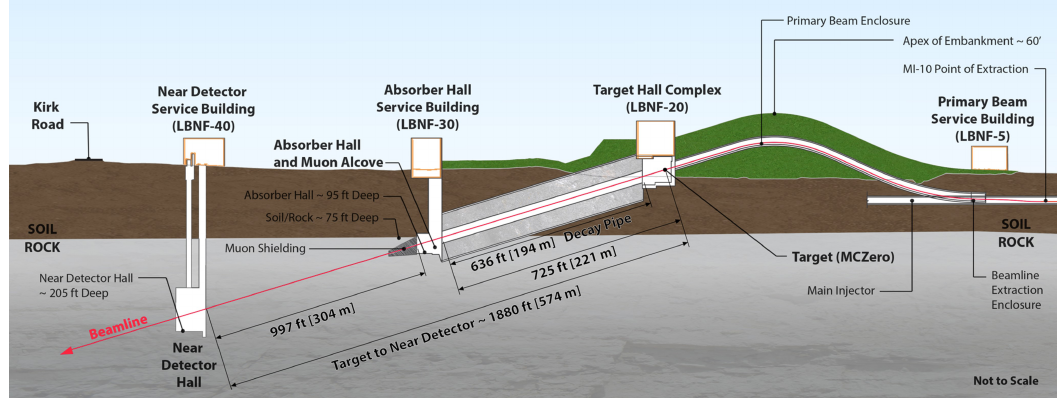
Figure 165. A cross-sectional view of the near site neutrino beamline. The near detector hall will be located about 570m from the proton beam target at an underground depth of approximately 60m.